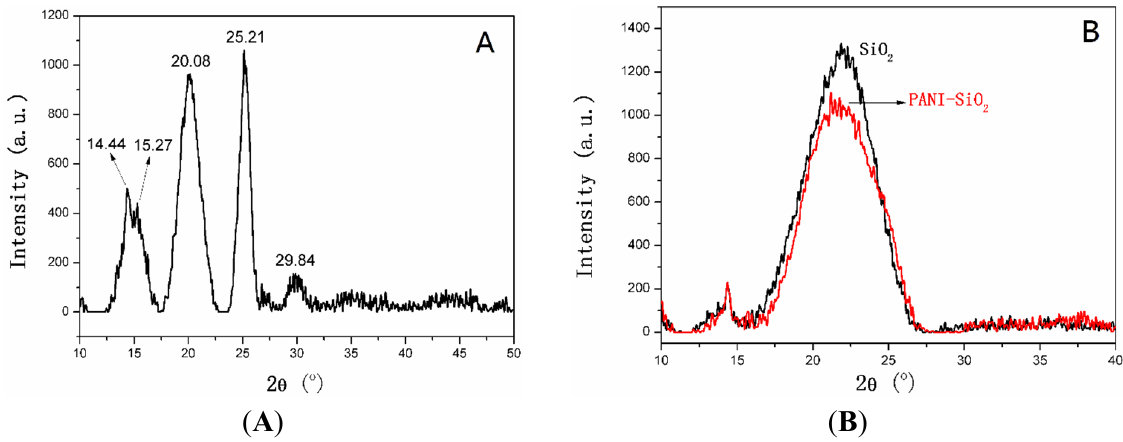
Figure 4. ( A ) X-ray scattering patterns of the bulk PANI. ( B ) X-ray scattering patterns of mesoporous silica and